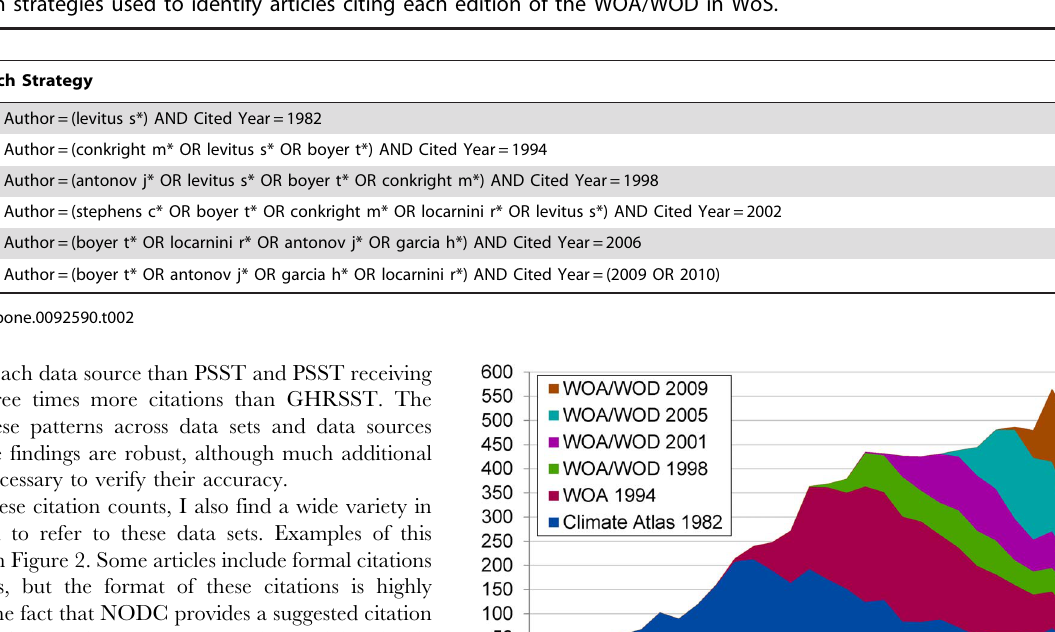
Table 2. Search strategies used to identify articles citing each edition of the WOA/WOD in WoS.